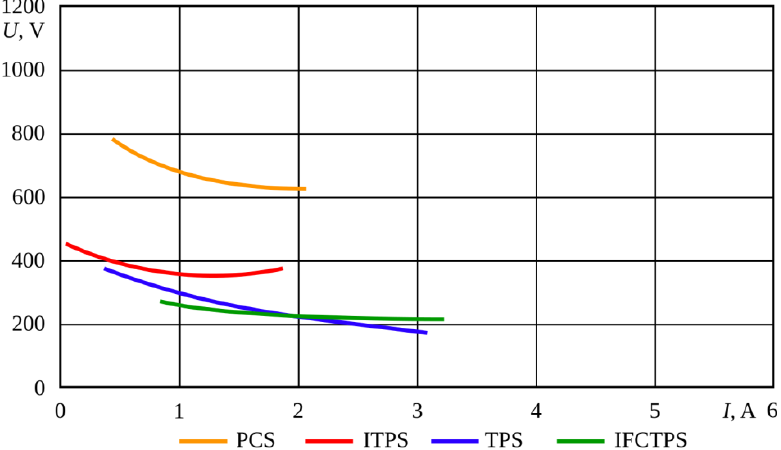
Figure 13. Control characteristics of the tested power supplies loaded with plasma reactor, plasma gas: helium, volumetric flow rate: 1.6 m 3 /h.